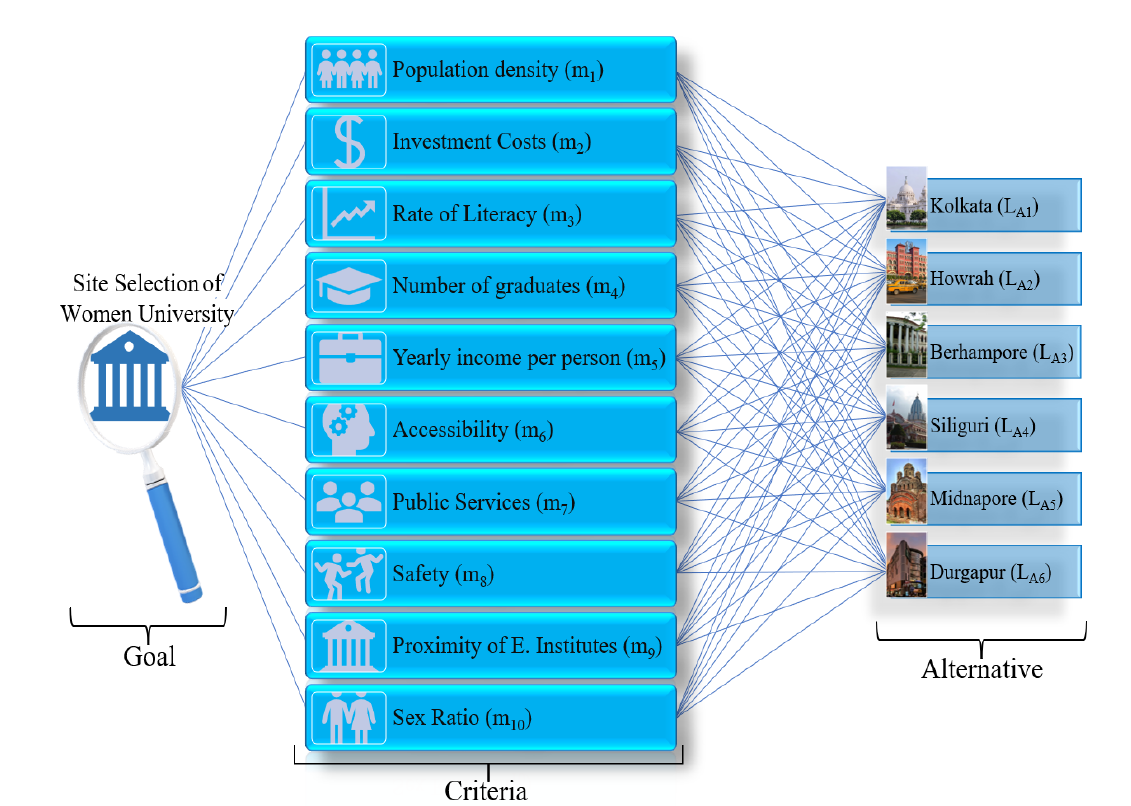
Figure 5. The Hierarchical structure of Women’s University site selection